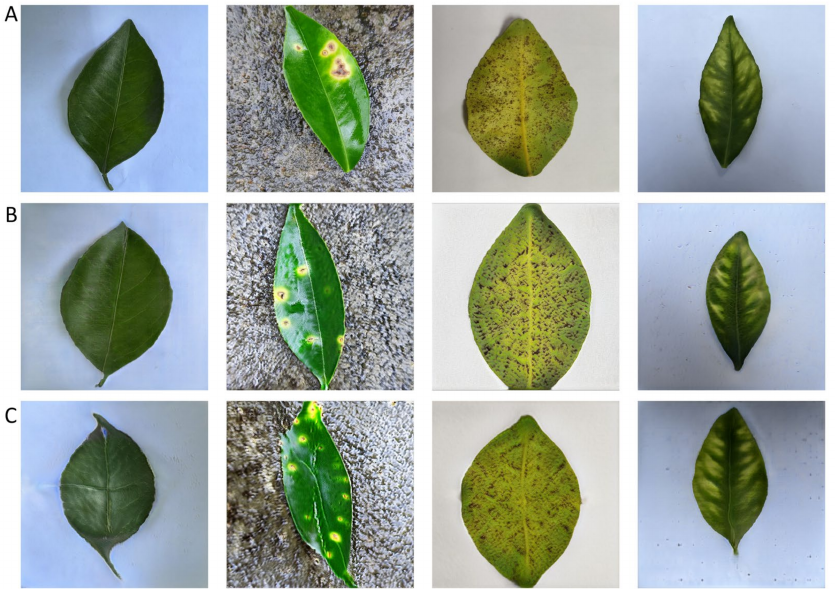
Figure 9. Comparison of four kinds of citrus leaf images generated by FastGAN and FastGAN2 with real images: ( A ) real dataset; ( B ) images generated by FastGAN2; ( C ) images generated by